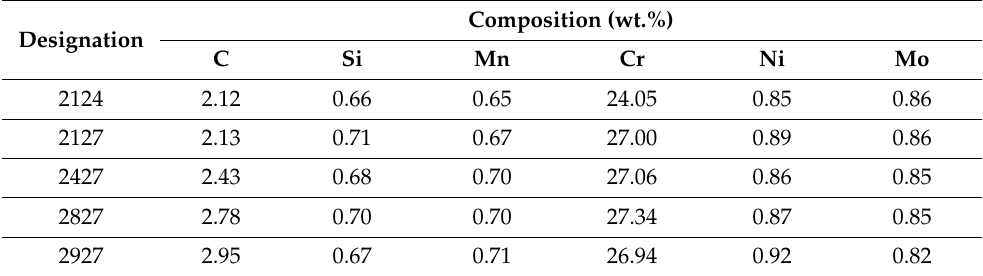
Table 1. Chemical composition of the experimental high-Cr white iron alloys